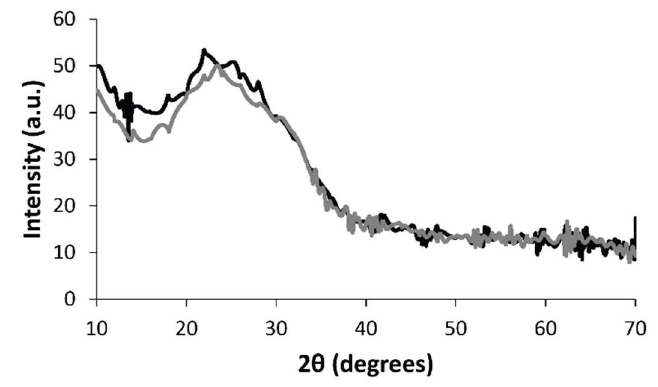
Figure 6. X-ray diffraction (XRD) data. (Black line) DMP-doped PPY film. (Gray line) MER-doped PPY film.